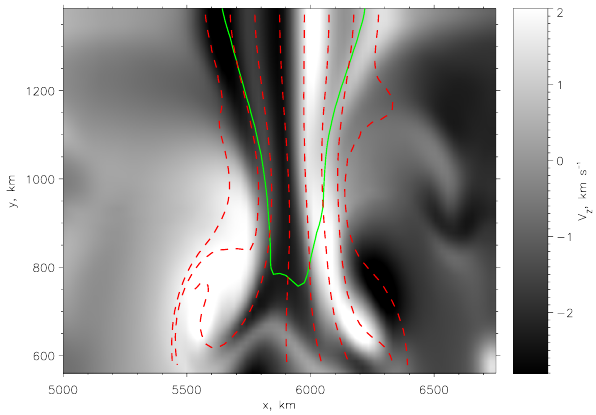
Fig. 7. A vertical cut through the vortex. The background image is the horizontal velocity component, perpendicular to the plane of the image. The solid green contour corresponds to the v A = c s layer. The dashed lines are the magnetic field